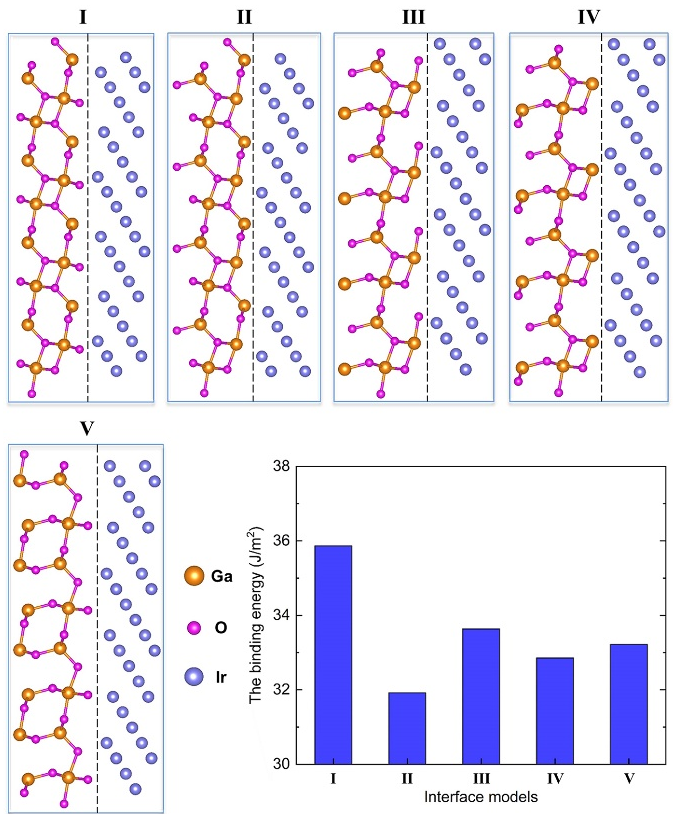
Figure 5. First-principles calculation of the β -Ga 2 O 3 /Ir interface. Models I–V are the possible atomic structure of the β -Ga 2 O 3 /Ir interface. The calculated binding energies (J/m 2 ) of five interface models are shown in the lower right of the figure.